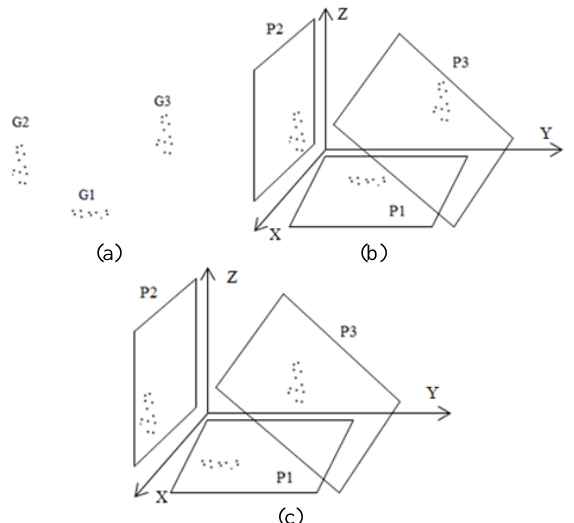
(c) Figure 1: (a) three groups of points; (b) and (c) two possible positions of points when fitting onto plane P1, P2 and